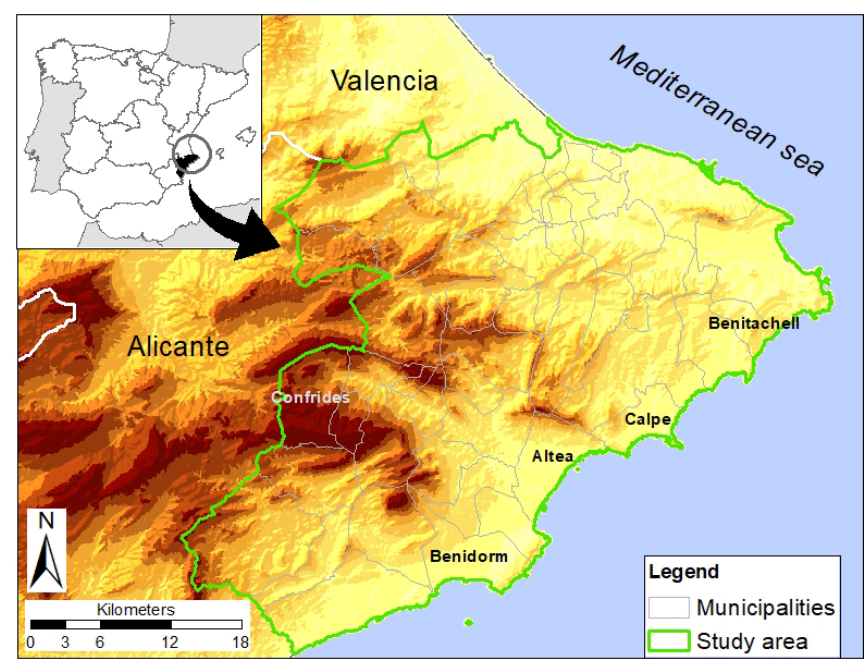
Figure 3. La Marina area. Location of some municipalities mentioned in the